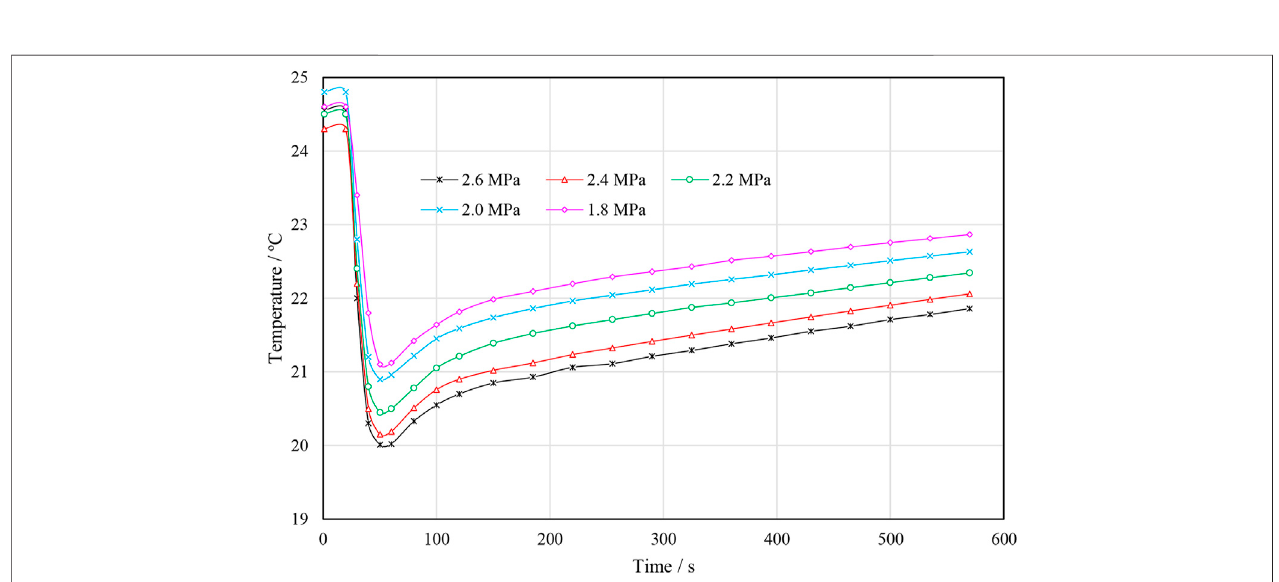
FIGURE 9 | Temperature variation of coal at the outburst ori fi ce after outbursts with different gas pressures from 1.8 to 2.6 MPa. Since there is no fractured coal fragments around the ori fi ce with the gas pressure at 1.2 – 1.6 MPa, the results is not presented.